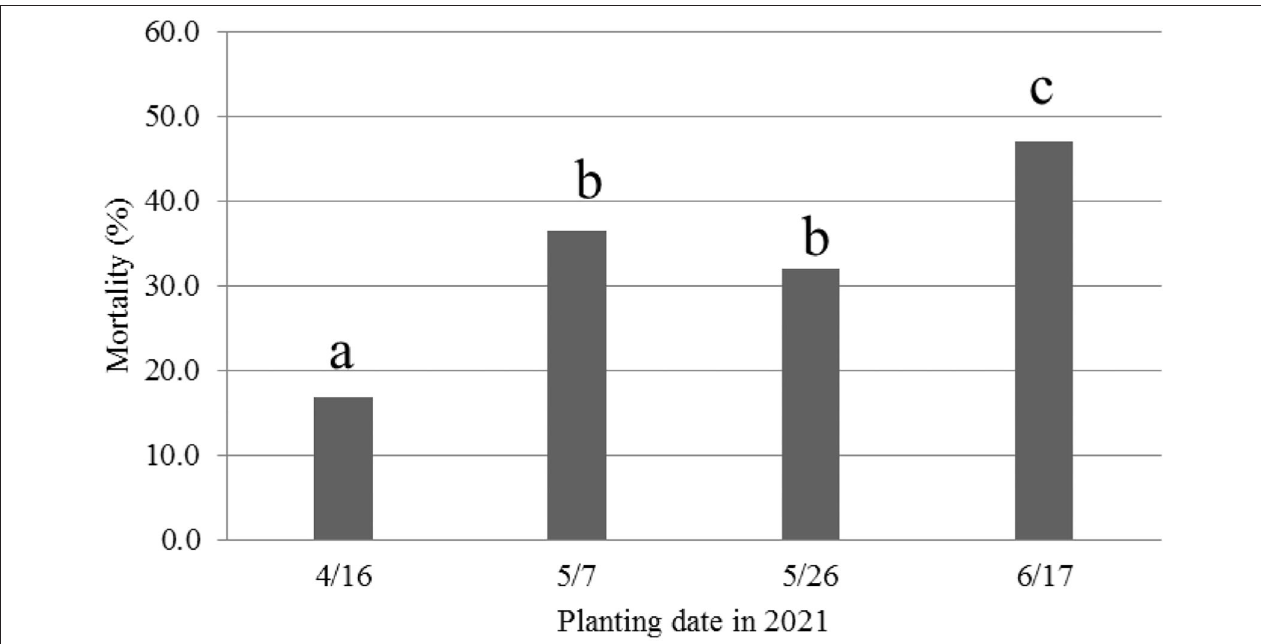
FIGURE 4 | Mortality rate (%) caused by Fusarium oxysporum f. sp. vasinfectum race 4 at 36 days after planting (DAP) from different planting dates in 2021. Different letters above the bars indicate significant differences.